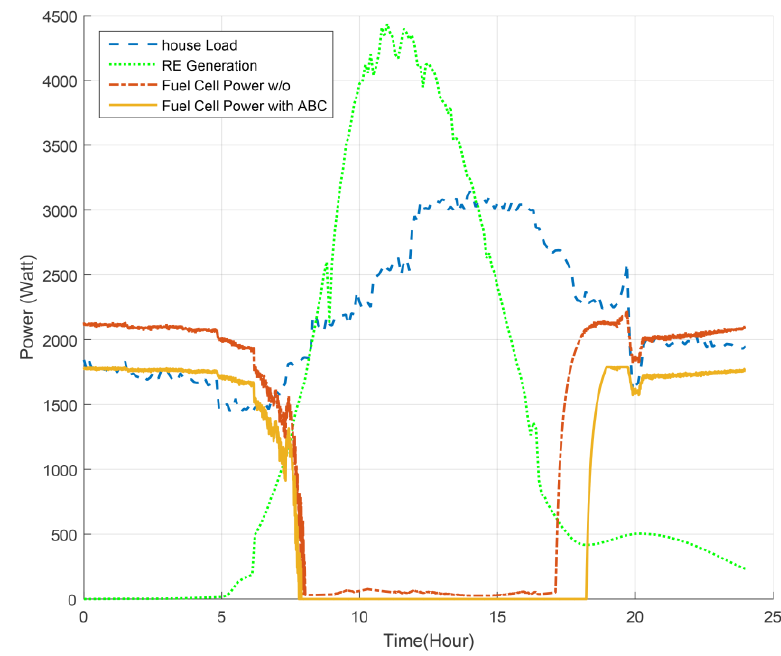
Figure 17. Operation of FC with / without optimization compared with REG and load demand for 24 h